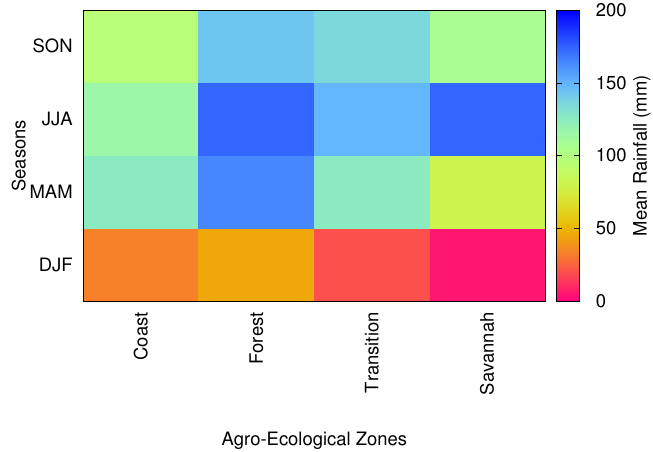
Figure 10. Seasonal mean rainfall amounts over the agro-ecological zones of